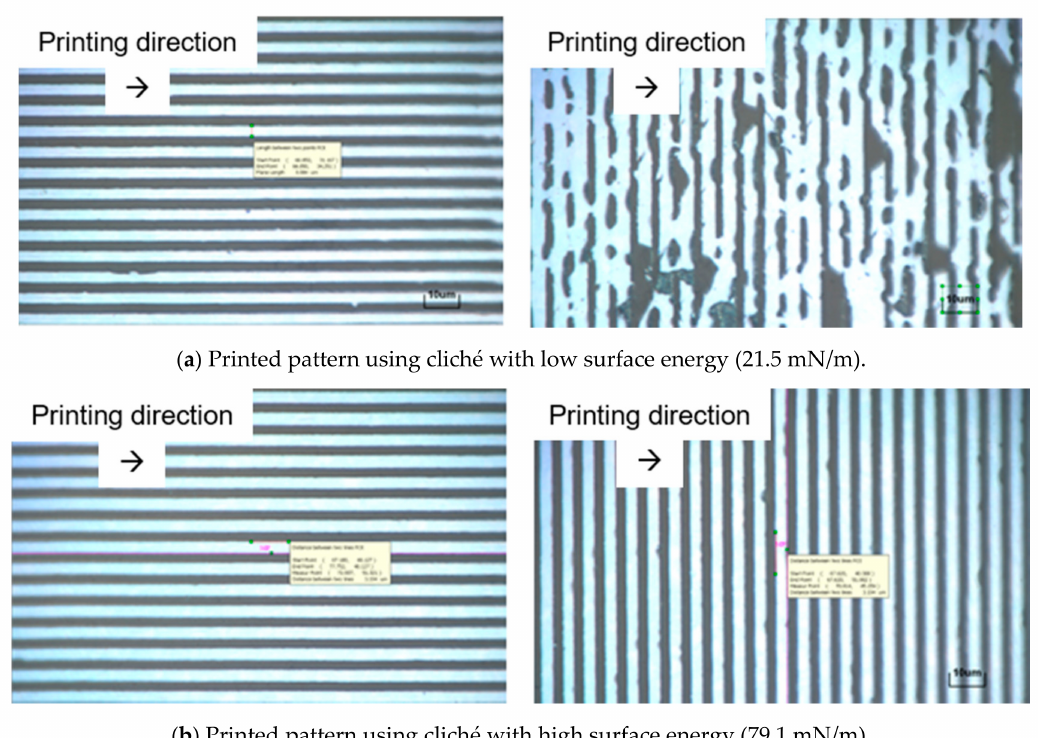
Figure 8. Angle dependency of printed pattern using clich é fabricated from different